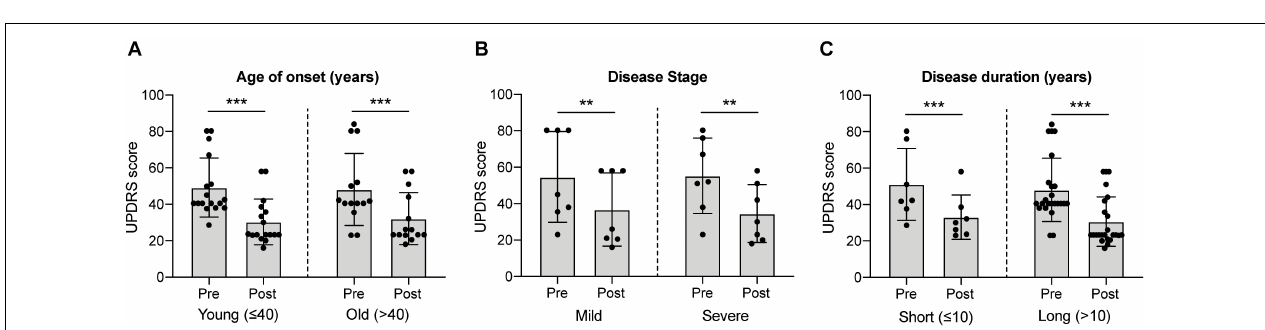
FIGURE 1 | Systematic analysis of various factors associated with clinical outcomes using positron emission tomography (PET) readings of Parkinson’s disease (PD) patients with fetal ventral mesencephalic (fVM) cell transplantation. Statistical comparison was performed on various parameters against fold change of PET readings pre- and post-transplantation. (A) Age on onset: old ( > 40 years) vs. young ( ≤ 40 years) PD patients. (B) Disease stage in mild and severe conditions. (C) Disease duration: long ( > 10 years) vs. short ( ≤ 10 years). Student t -test, * p < 0.05, *** p < 0.001.